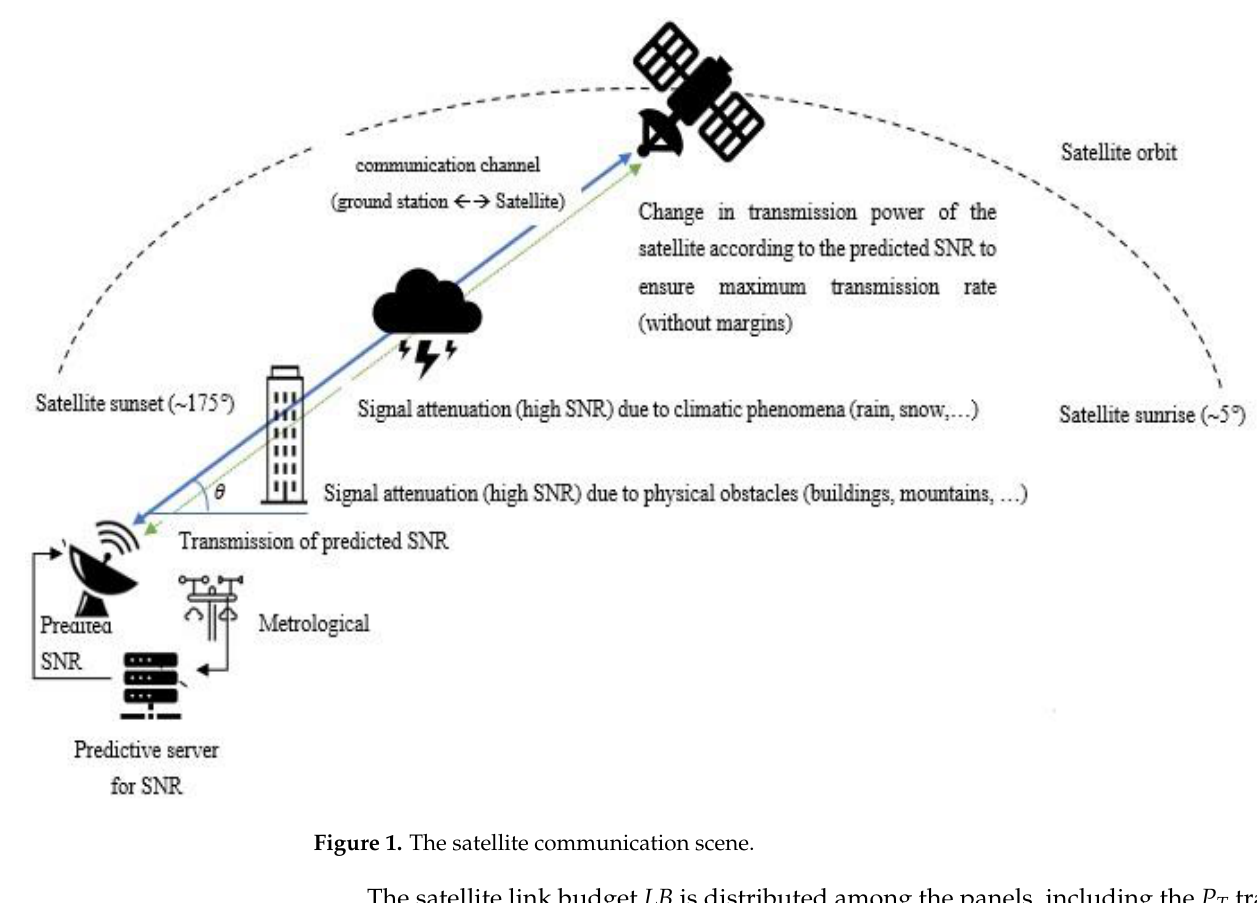
Figure 1. The satellite communication scene.